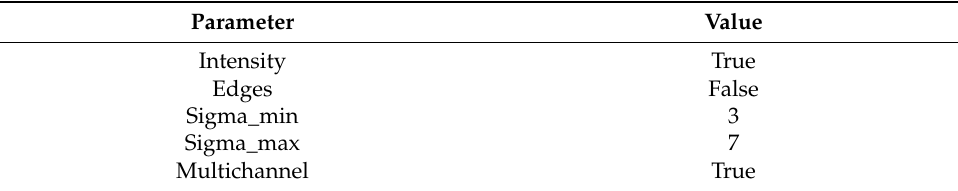
Table 1. Parameters used as MBFs.